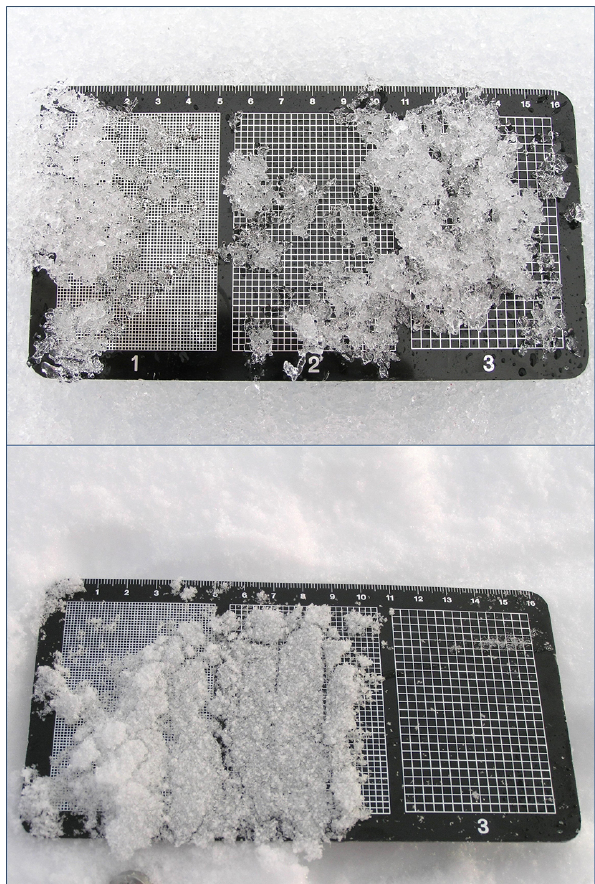
Figure 1. Typical grains of white ice (top panel) and fresh snow (bottom panel) observed in the central Arctic during ARK XXVII/3 in 2012. The size of the underlying grid is 1, 2, and 3mm, respec- tively.